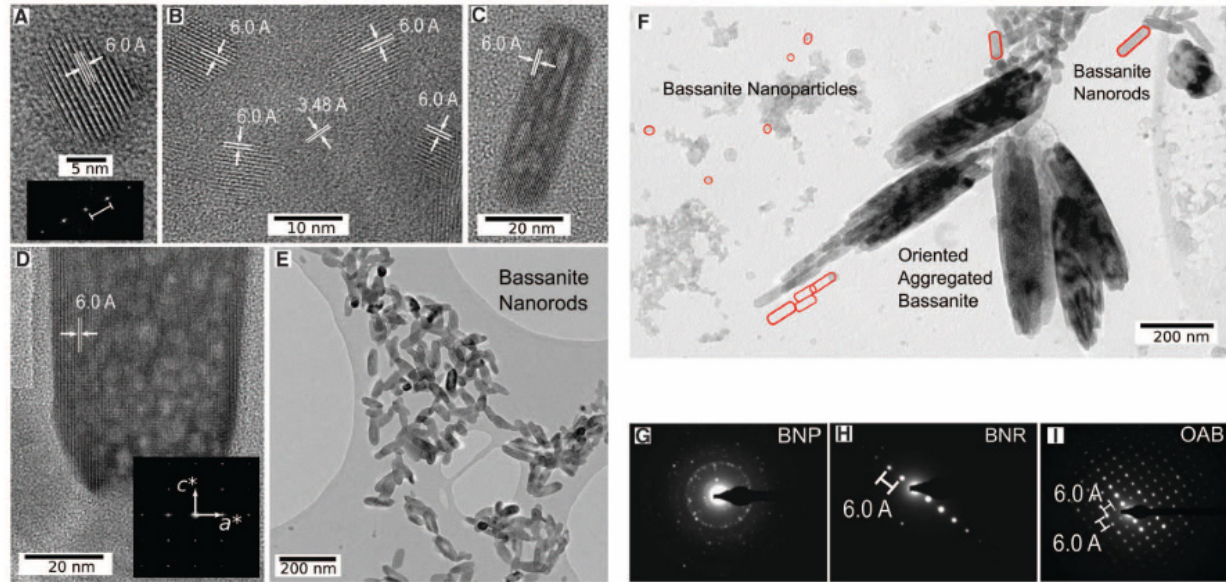
Figure 8. High Resolution Transmission Electron Microscopy (HR-TEM) microphotographs from the bassanite growth via vacuum/solvent filtration and cryo-quenching. ( A ) Typical bassanite particle. ( B ) Set of bassanite nanoparticles with representative 6.0 and 3.48 Å d-spacings. ( C ) small and ( D ) large bassanite nanorods. ( E ) Bassanite nanorods oriented prior to aggregation. ( F ) Bassanite nanorods and coexisting nanoparticles. Areas selected for electron diffraction ( G ), bassanite nanorods with reciprocal lattice in c-axis ( H ), and aggregated bassanite with reciprocal lattice along c and a axes ( I ). Figure from Van Driessche et al. (2012) [11]. BNP = Bassanite nanoparticles; BNR = Bassanite nanorods; OAB = Oriented aggregated bassanite.